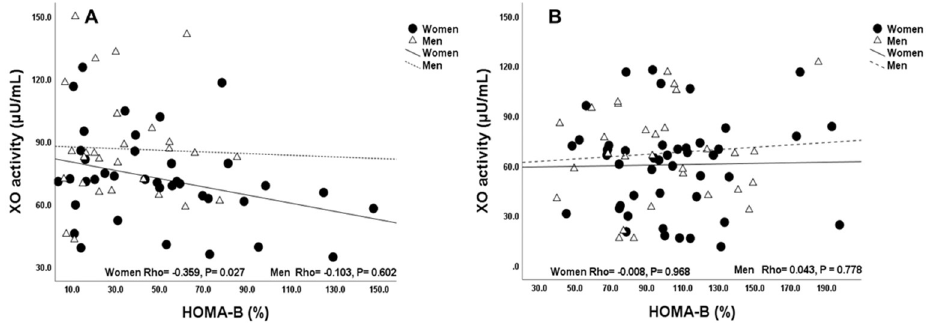
Figure 2. Association between serum XO activity and HOMA- β in overweight women and men with and without T2D. ( A ) T2D. ( B ) Non-T2D. The p values were estimated form Spearman’s correlation analyses. p < 0.05 was considered significant. Abbreviations: Xanthine oxidase (XO), Homeostatic Model Assessment of β-cell function (HOMA-β).